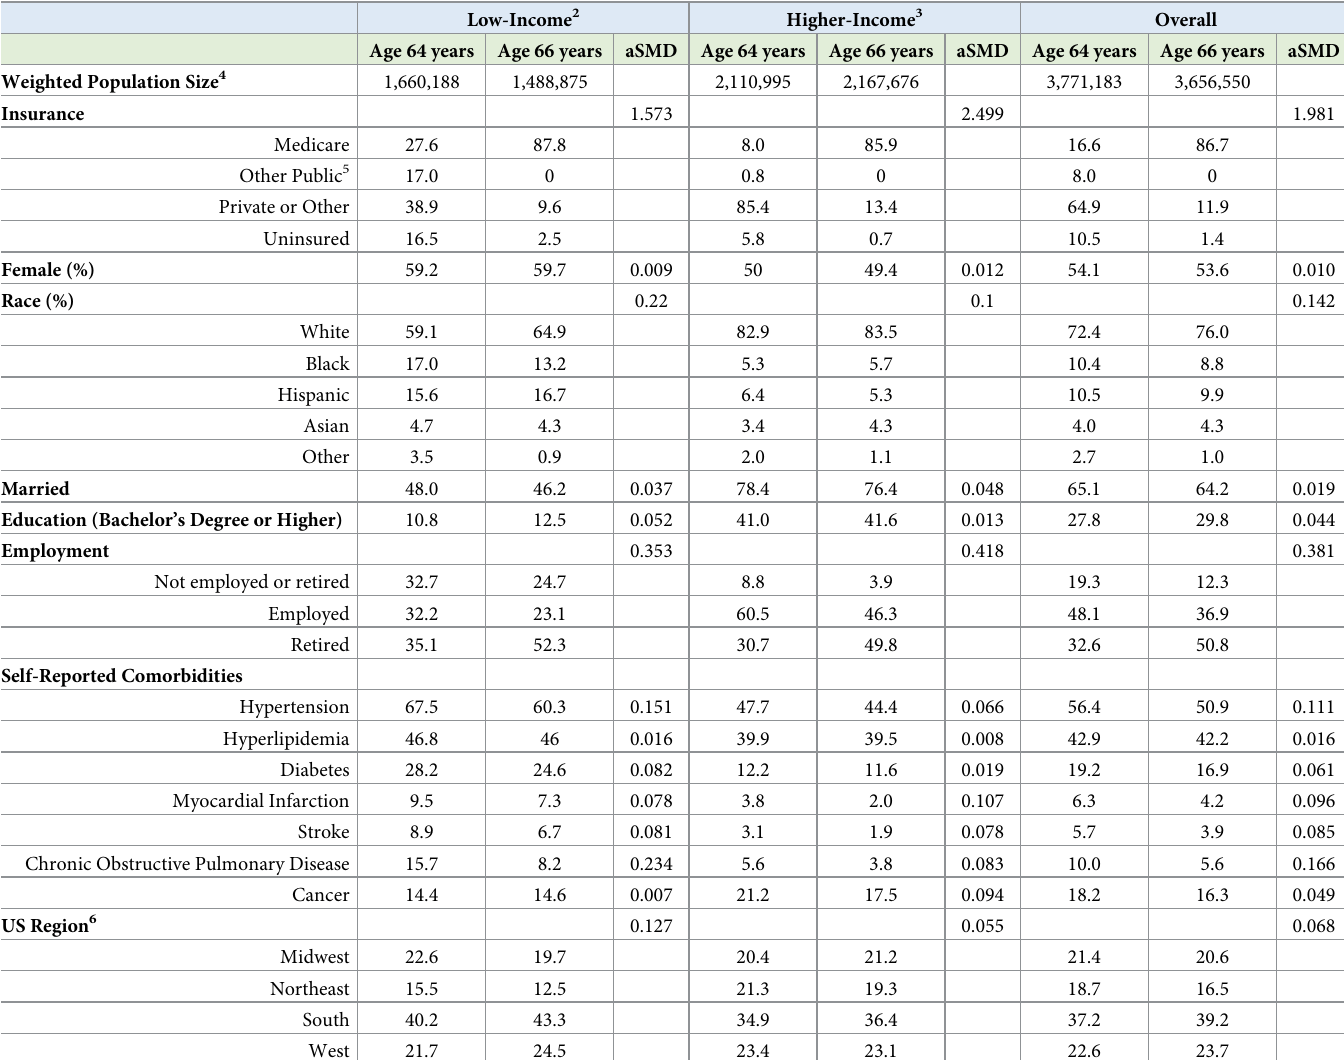
Table 1. Baseline characteristics of the US population ages 64 and 66 years by income level 1 . Low-Income 2 Higher-Income